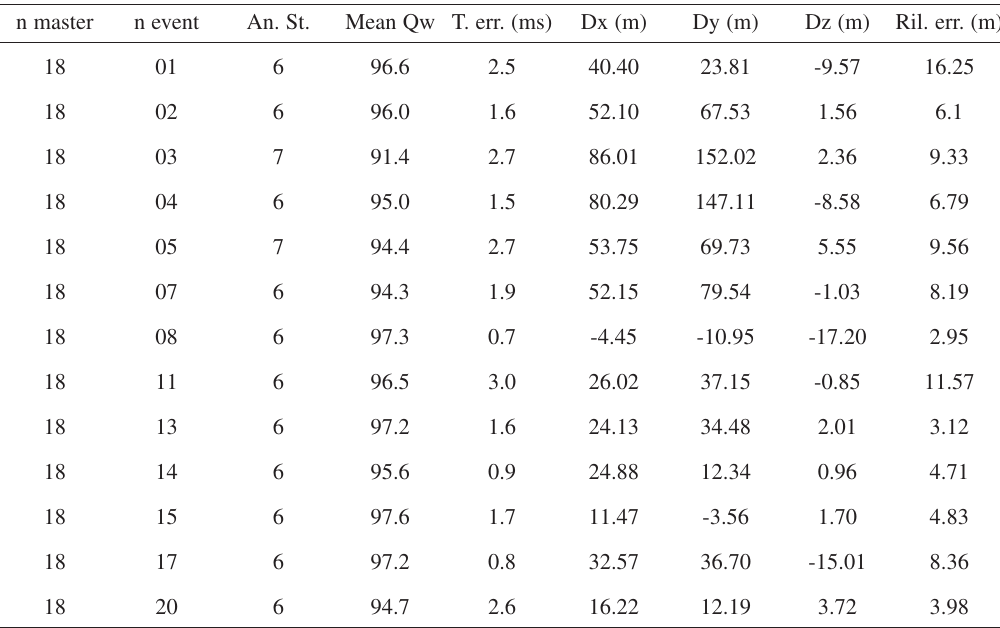
Table II. Results of the event relocation.